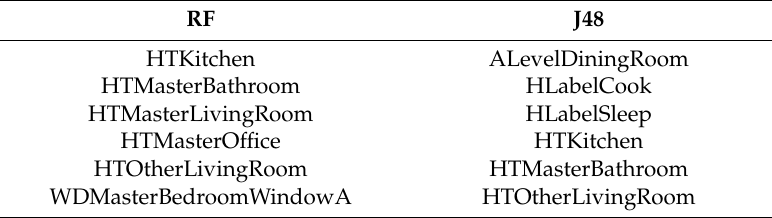
Table 12. Selected SH attributes that as a group predict indoor methanol in IAQ 2 . RF